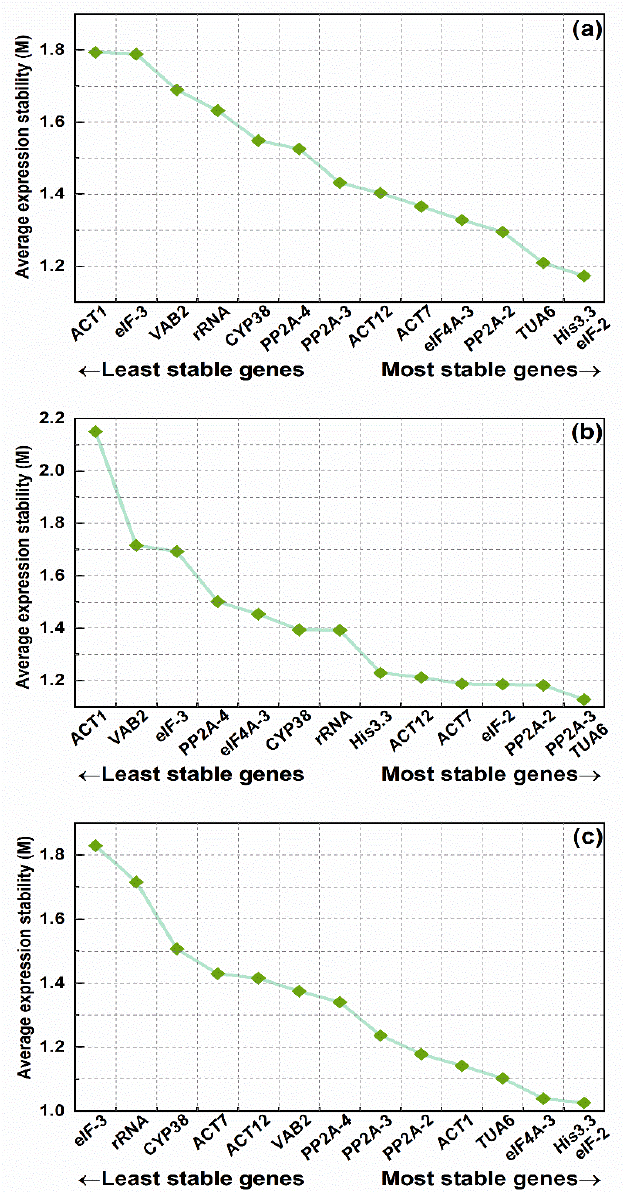
Figure 3. Gene expression stability and ranking of fourteen reference genes based on geNorm. The expression stability value (M) for each gene was obtained and graphed. The lower the M value, the more stable the expression. The most stable genes are on the right and the least stable genes are on the left. ( a ) Total samples: all root, stem, leaf, and spike samples of P. vulgaris ; ( b ) different organs: root, stem, leaf, and spike samples during the full flowering stage; ( c ) different periods: Spica Prunellae from four stages: bolting stage, early flowering stage, full flowering stage, maturity stage.